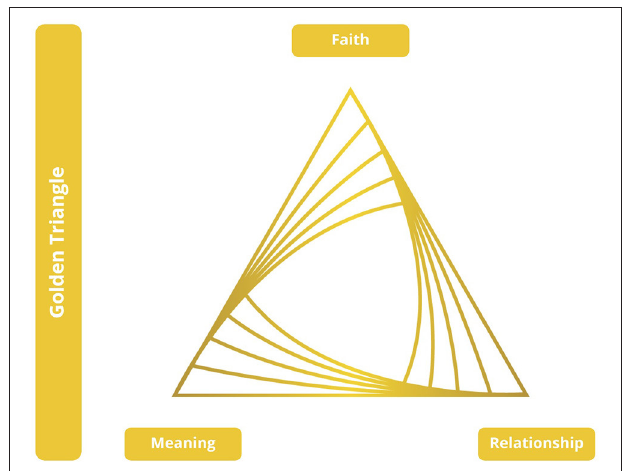
FIGURE 1 | The Golden Triangle, based on Wong